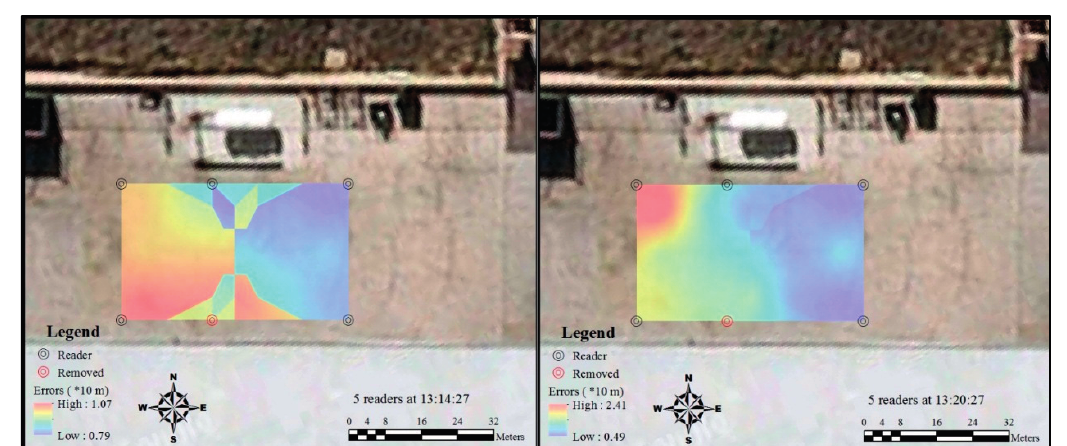
Figure 10. Spatial and temporal variation of RFID errors distribution by five readers.